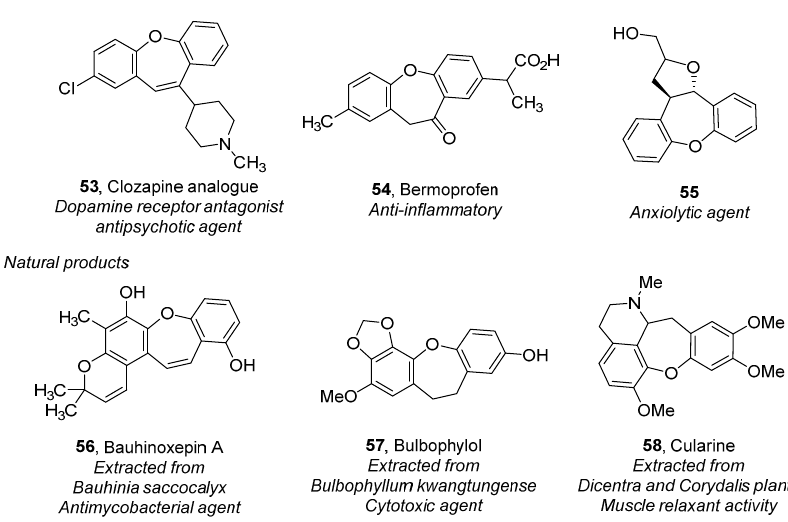
Figure 5. Relevant examples of bioactive dibenz[ b , f ]oxepines.